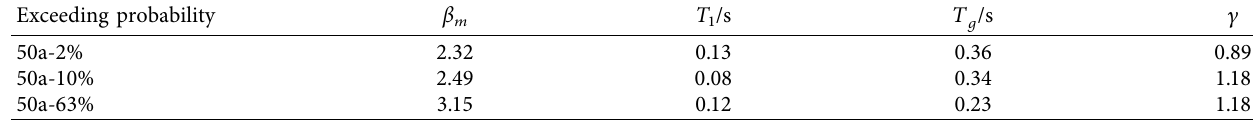
Table 9: Design spectrum characteristic parameters calibrated by the differential evolution algorithm.